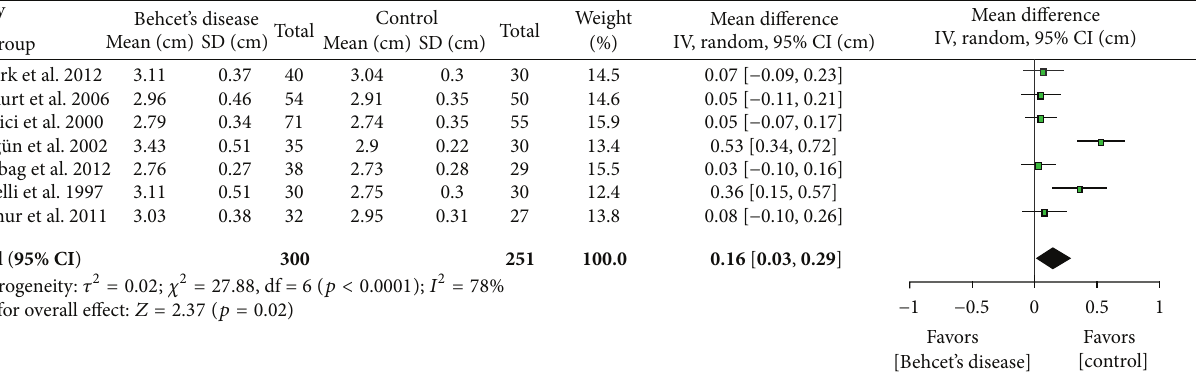
Figure 1: Aortic size comparison between patients with Behcet’s disease and